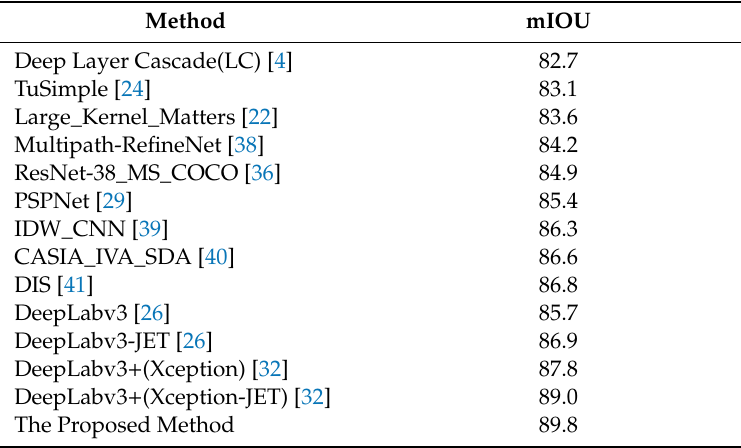
Table 3. Results of accuracy (mIOU) for the proposed method and methods from the literature on images in the PASCAL VOC 2012 database.